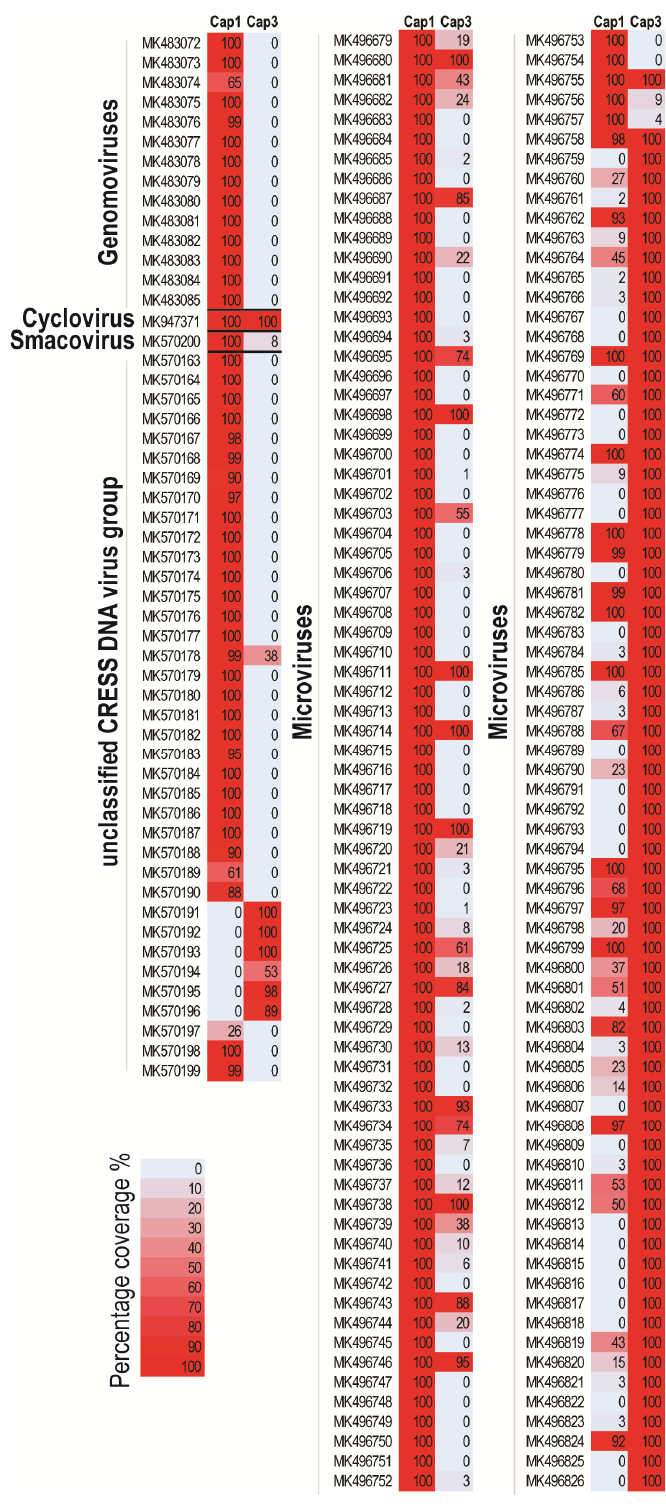
Figure 1. Percentage coverage of raw reads mapped from samples Cap1 and Cap3 against all genomes recovered in this study.